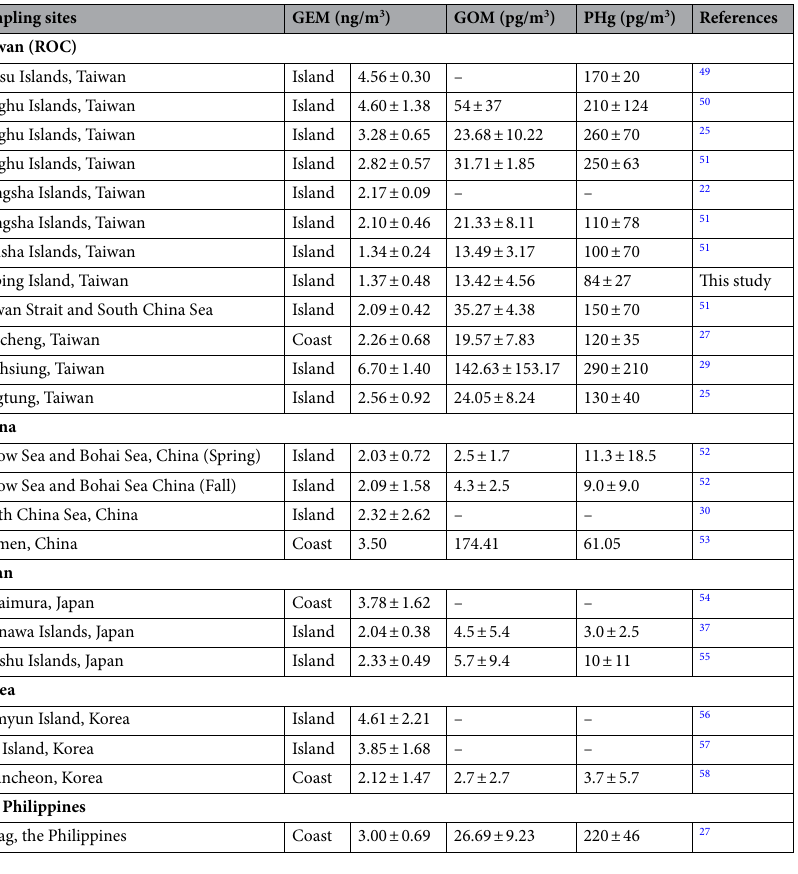
Table 4. Comparison of atmospheric speciated mercury concentrations at remote islands and coastal sites in the East